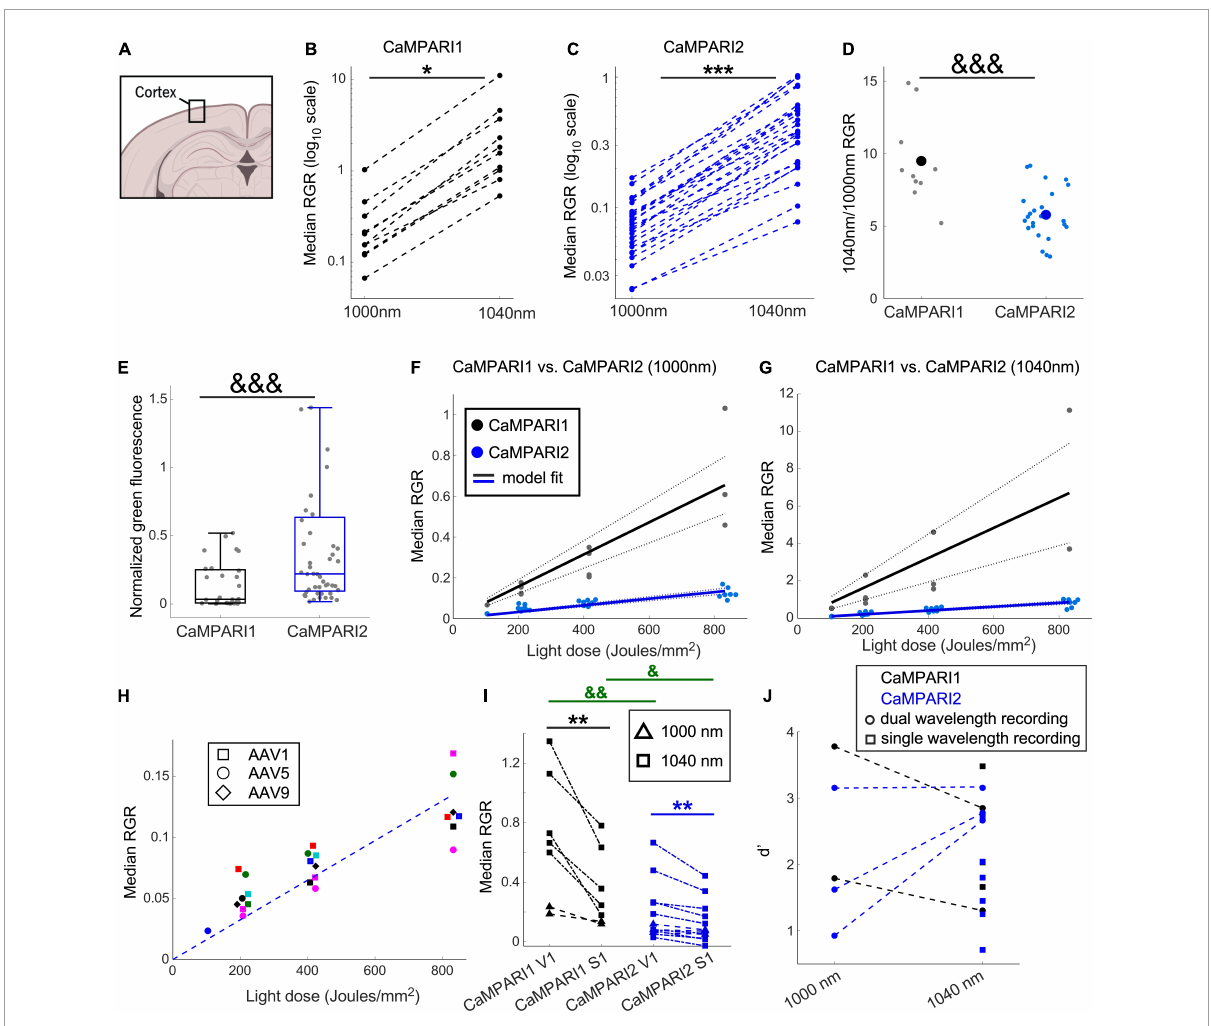
FIGURE2 Comparing the PC performance of CaMPARI1 and CaMPARI2 in the mouse V1. (A) Schematic illustration of cortical recording. (B,C) Comparing the median RGR for CaMPARI1 (B) and CaMPARI2 (C) shows the increased RGR with longer wavelength excitation. RGR was recorded from all identified neurons in V1, and each dot is a median across all cells from the same mouse on a single recording data were acquired from 4 CaMPARI1 mice, each mouse recorded with 2–3 different light doses ( n = 443, 234, 185, and 571 cells from each mouse), and 11 CaMPARI2 mice, each mouse recorded with 1–3 different light doses (minimal and maximal numbers of cells/mice were 145 and 1,504, respectively; median value was 526). The RGR readout was performed sequentially for each mouse using 1,000 nm and then 1,040 nm excitation wavelengths. Lines connect the data points acquired from the same mouse during the same session. Note the logarithmic scale of the y-axis. (D) The ratios of median RGR values acquired from the same mice at 1,040 and 1,000 nm excitation wavelengths were significantly higher for CaMPARI1 than CAMPARI2 mice [9.05 ± 3.06 vs. 5.8 ± 1.75, respectively, mean ± std.; p = 0.0009, Wilcoxon Ranksum Test; data from the same mice as in (B,C)] . Small circles show the ratio for median from individual recordings and the large circles are the mean across all data points. (E) The median somatic green fluorescence from all neurons within a single FOV before PC (normalized to the square of the excitation power at 1,000 nm) was significantly higher for CaMPARI2 than CaMPARI1, in agreement with the previously published in vitro characterization of the CaMPARI constructs (Moeyaert et al., 2018) (data from n = 28 and 48 fields of view located 100–150 µ m under the pia of 5 and 7 CaMPARI1- and CaMPARI2-expressing mice, respectively; 2–82 cells/field of view, with a median number of 27; p = 0.0003, Wilcoxon Rank Sum Test). Each box shows the respective 25–75 percentile of this distribution, horizontal lines show the median values, and the whiskers span the distance from the boxes to the extreme data points. (F) The median RGR across all recorded cells showed linear increases with the light dose used for PC, with substantially higher PC rates for CaMPARI1 than CaMPARI2. The individual data points (gray and blue circles for CaMPARI1 and CaMPARI2, respectively) show the median RGR across all cells within a single mouse in a single light dose recording. Data were acquired from 6 CaMPARI1 mice recorded 1–3 times with different light doses (185–2,759 cells/mice and median value of 470 cells/mice) and from 11 CaMPARI2 mice recorded 1–3 times with different light doses (145–1,504 cells/mice and median value of 526 cells/mice). Data were fit with a linear model with zero intercept [black and blue solid lines for CaMPARI1 and CaMPARI2, respectively; slopes of 7.9 × 10 − 4 and 1.6 × 10 − 4 (RGR/light dose) for CaMPARI1 and CaMPARI2 and p = 3 × 10 − 7 and p = 2.6 × 10 − 16 for the model fit vs. null hypothesis, respectively; two-tailed t -tests]. Dashed lines show 95% confidence intervals. (G) Same representation as in (F) for excitation with 1,040 nm [slopes of 8 × 10 − 3 and 1 × 10 − 3 (RGR/light dose) for CaMPARI1 and CaMPARI2 and p = 0.0003 and p = 2 × 10 − 11 for the model fit vs. null hypothesis for CaMPARI1 and CaMPARI2, respectively; two-tailed t -tests; data from 4 CaMPARI1 mice with 443, 234, 185, and 571 cells/mouse; same CaMPARI2 mice as in (F) ]. (H) No apparent change in CaMPARI2 PC efficiency was identified when it was expressed using three different AAV serotypes. Same CaMPARI2 data as